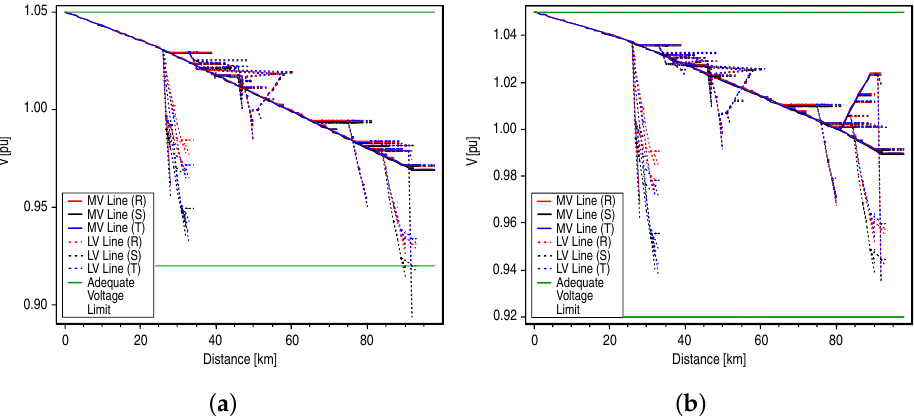
Figure 12. Scenario 1: ( a ) voltage profile before DGPV allocation and ( b ) voltage profile after DGPV